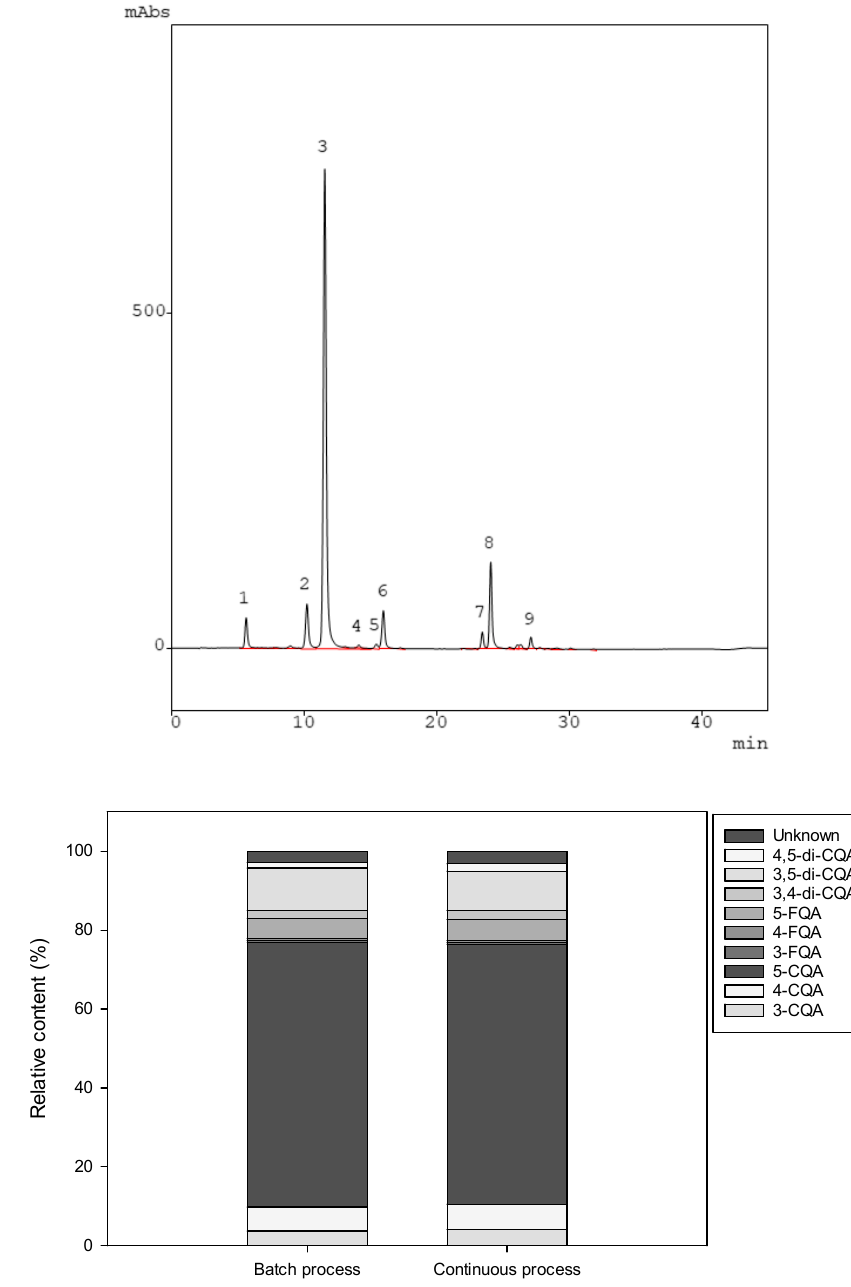
Figure 4. An exemplary chromatogram of green coffee beans obtained from batch processing ( a ) and the composition of the major phenolic compounds ( b ). (1) 3-O-Caffeoylquinic acid (3-CQA), (2) 4-O-Caffeoylquinic acid (4-CQA), (3) 5-O-Caffeoylquinic acid (5-CQA), (4) 3-O-Feruloyquinic acid (3-FQA), (5) 4-O-Feruloyquinic acid (4-FQA), (6) 4-O-Feruloyquinic acid (5-FQA), (7) 3,4-O-Dicaffeoylquinic acid (3,4-di-CQA), (8) 3,5-O-Dicaffeoylquinic acid (3,5-di-CQA), (9) 4,5-O-Dicaffeoylquinic acid (4,5-di-CQA), allocation as reported in [26] .